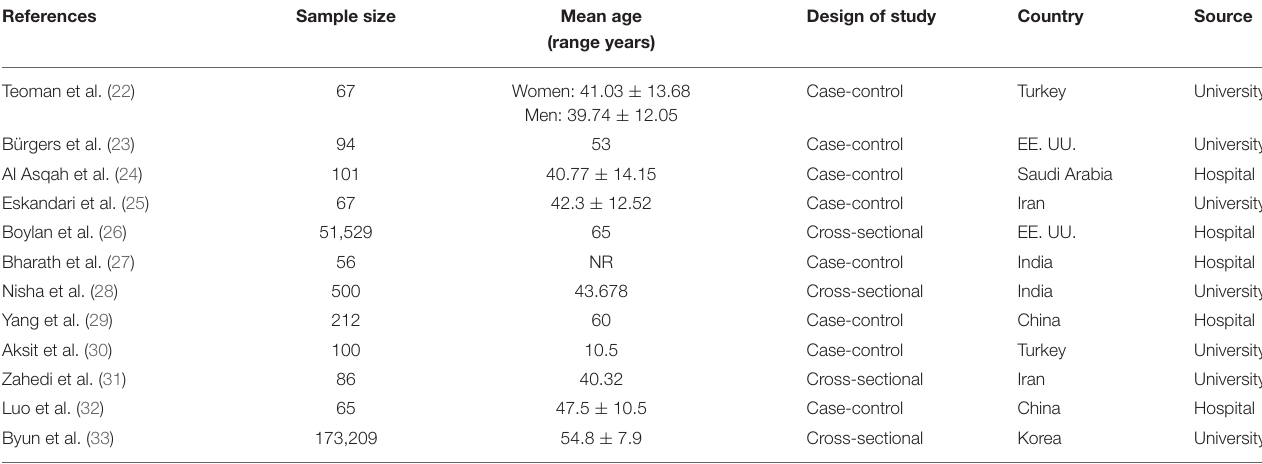
TABLE 1 | Characteristics of studies.